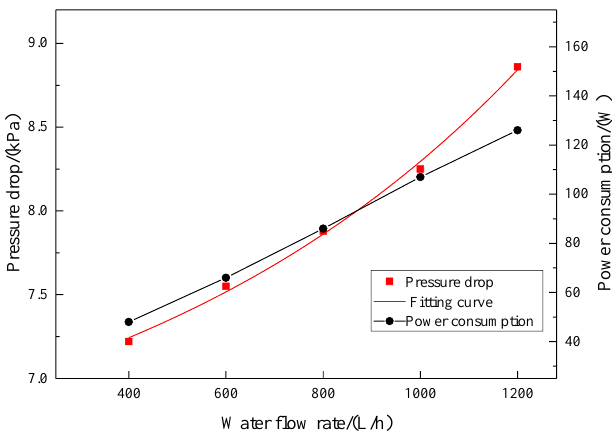
Figure 20. Pressure drop and power consumption of water side.